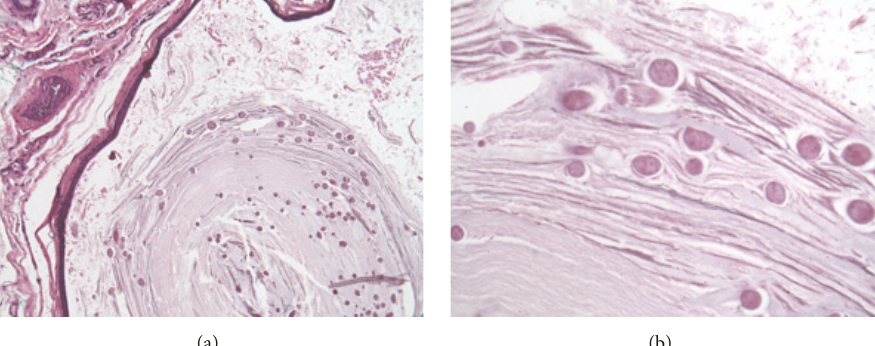
Figure 4: Representative photomicrograph of EVHC stained with H&E at 100x (a) and 400x (b) magnification. Keratin and numerous vellus hair shafts are visible in the cyst